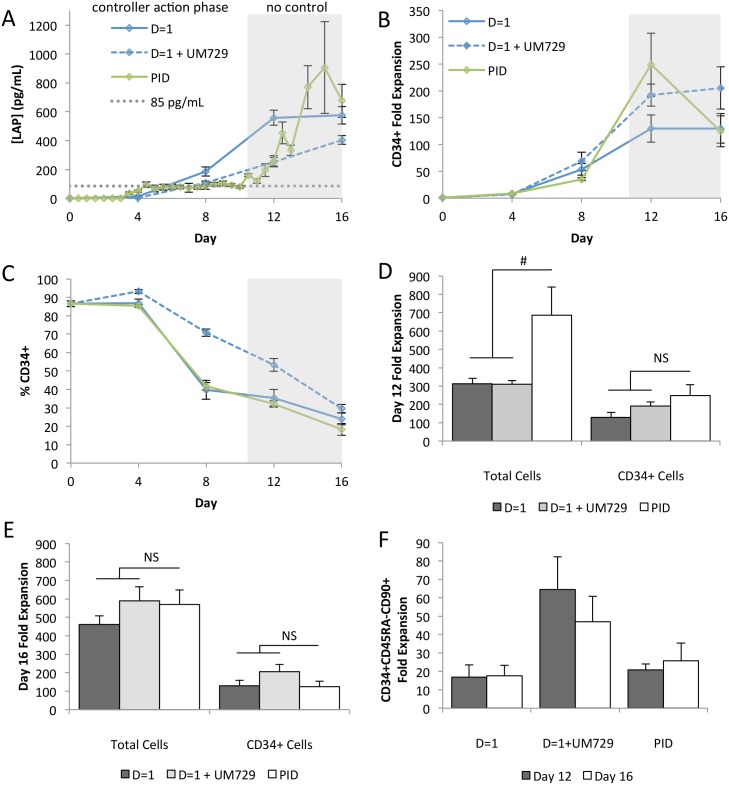
PID control is an effective alternative to supplementation with UM729.
[A] Our PID feedback controller has a similar effect on the concentration of LAP as UM729 addition with the PID controller conditions have a significantly higher concentration only at day 4 (n = 3). [B] Time course CD34+ expansion shows that PID control performs at least as well as D = 1+UM729 at day 12. [C] UM729 inhibits differentiation, resulting in a higher proportion of CD34+ cells beyond day 4. Both conditions have a significant loss of this phenotype between days 12 and 16 (D = 1+UM729 p = 0.007, PID p = 0.047) (n = 3). [D] At day 12, PID control moderately outperforms D = 1+UM729 with regards to total cell expansion. CD34+ cell expansion is equivalent (p = 0.444) (n = 3). [E] When culture time is extended to day 16, PID control and D = 1+UM729 remain equivalent (total cells p = 0.871, CD34+ cells p = 0.178) (n = 3). [F] Higher expansion of the HSC-enriched population, CD34+CD45RA-CD90+, is observed in D = 1+UM729 conditions at both day 12 and day 16, though the difference is not significant. # p<0.1 NS p>0.1.